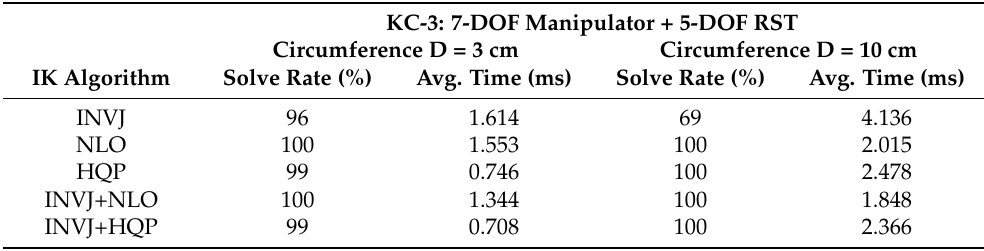
Table 6. A comparison of the solve rate and the solving time for single-method and concurrent IK algorithms. The target trajectories are two circular paths with diameters of 3 cm and 10 cm. Evaluation is performed for the KC-3 kinematic chain (Manipulator + Hyper-redundant RST).